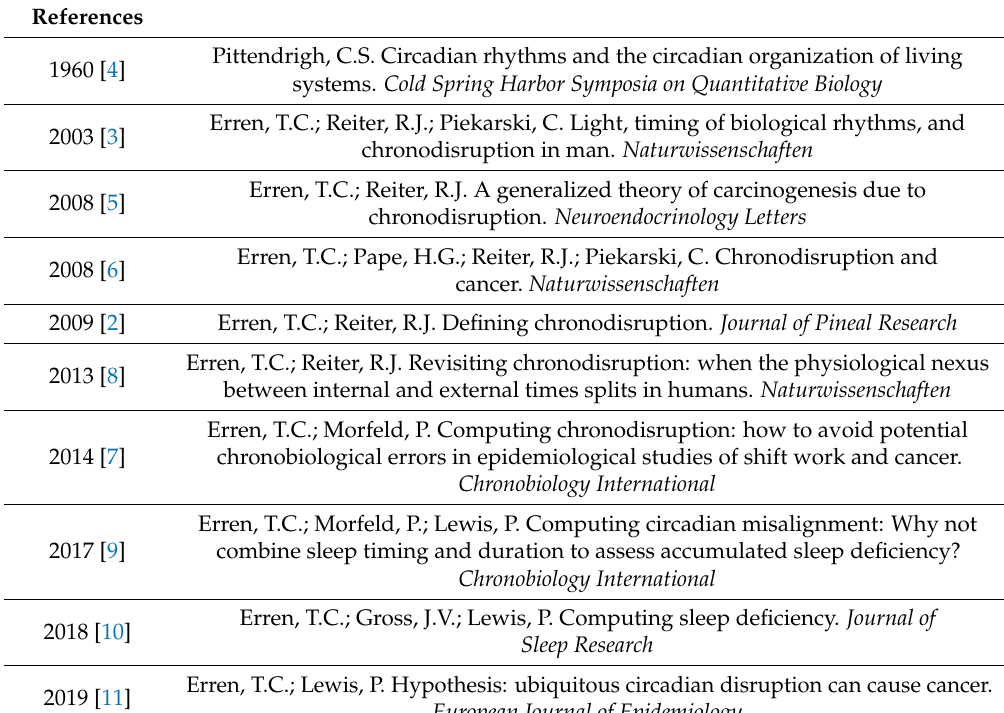
Table 1. Origin, roots, and developments of the term and concept of